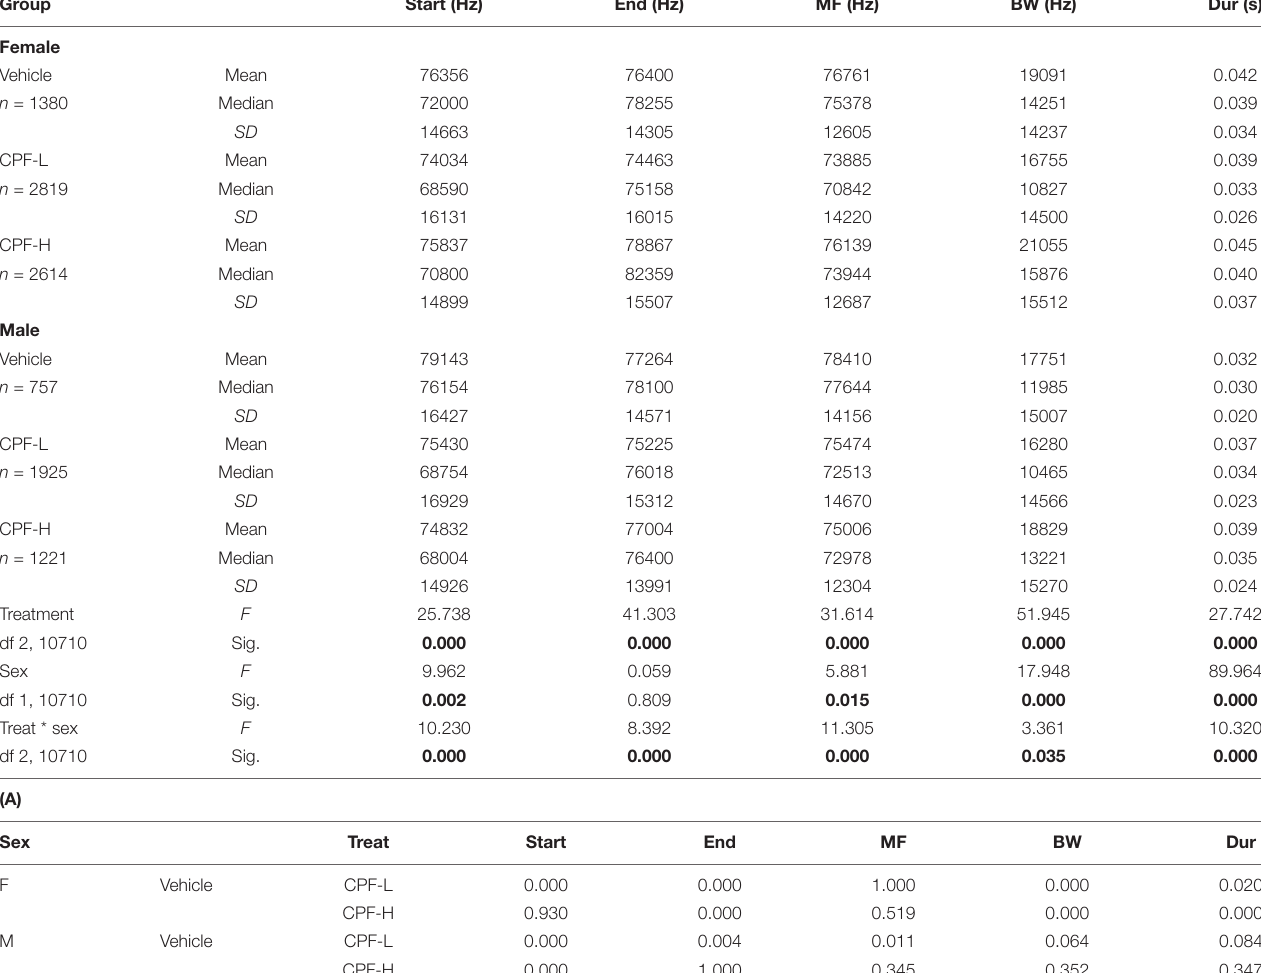
TABLE 1 | The effect of CPF treatment and sex on isolation induced